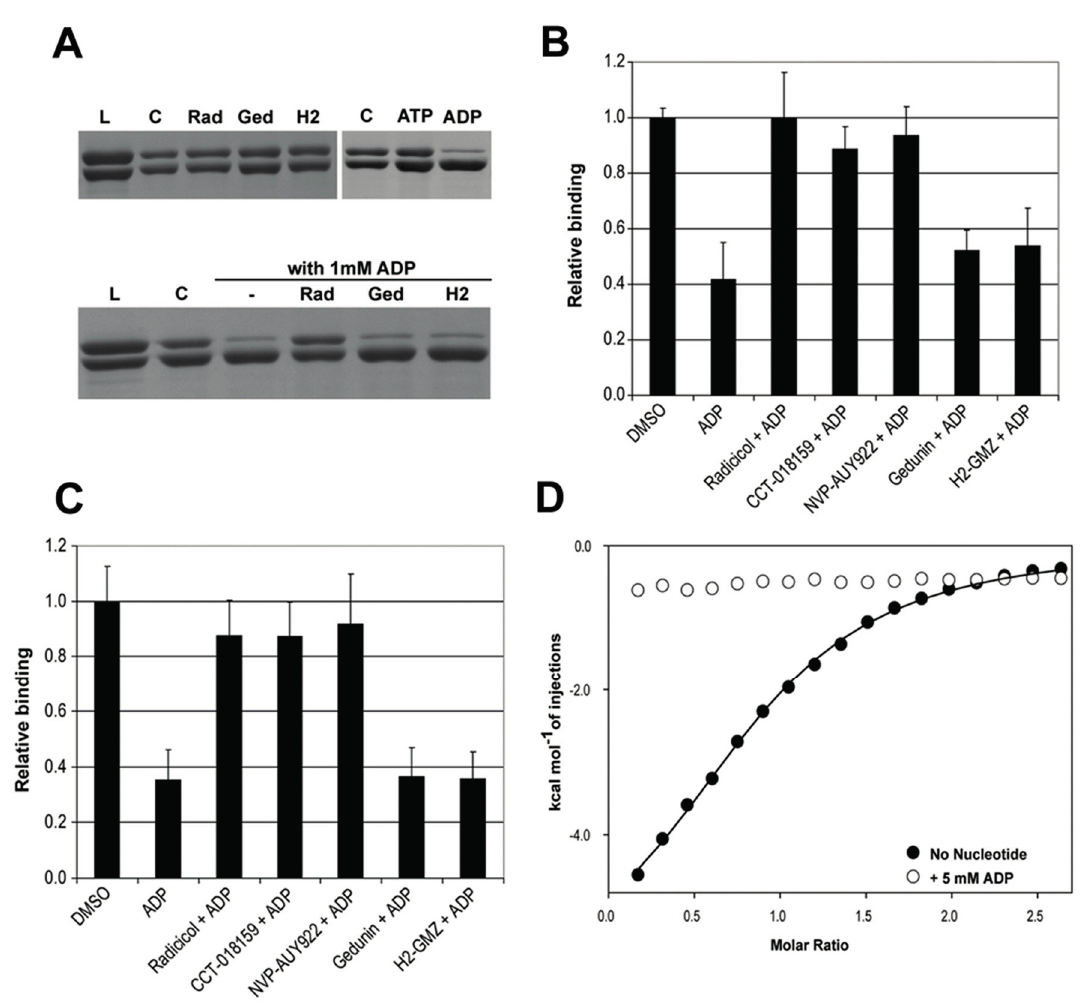
ND-1000 spectrophotometer.